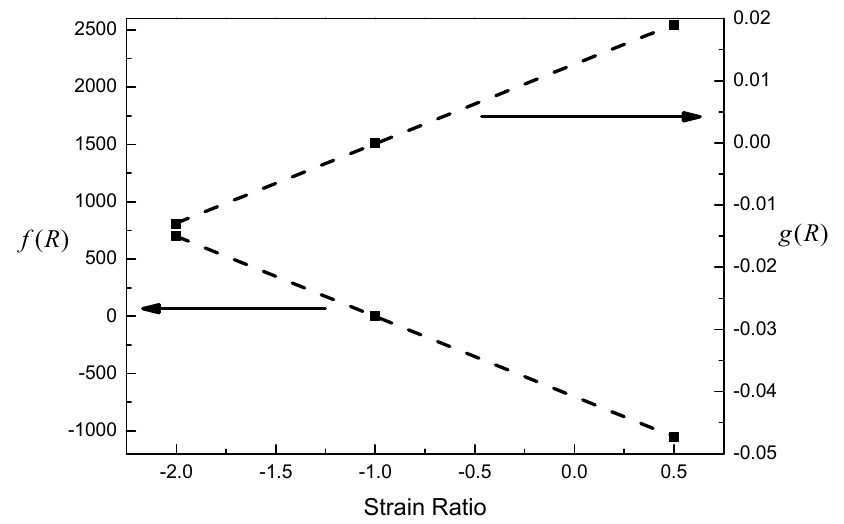
Figure 6. Relationships between f ( R ) and g ( R ) and strain ratio.